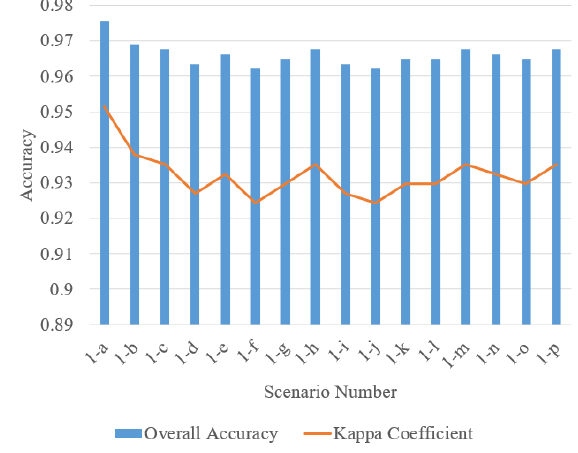
Figure 7. Overall Accuracy and Kappa Coefficient of the first series of implementations